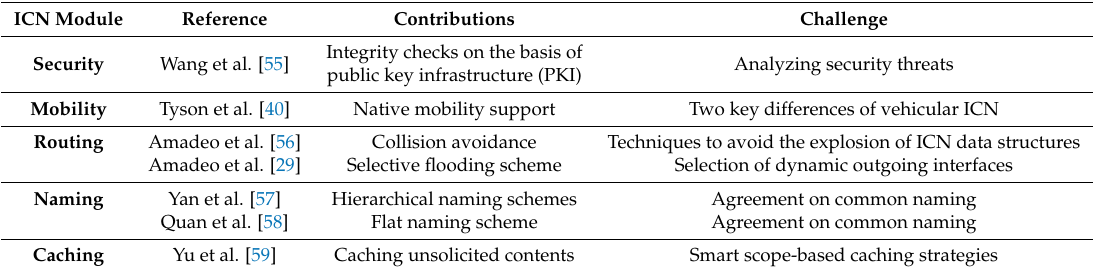
Table 1. Summary of ICN-based Vehicular Communications Research